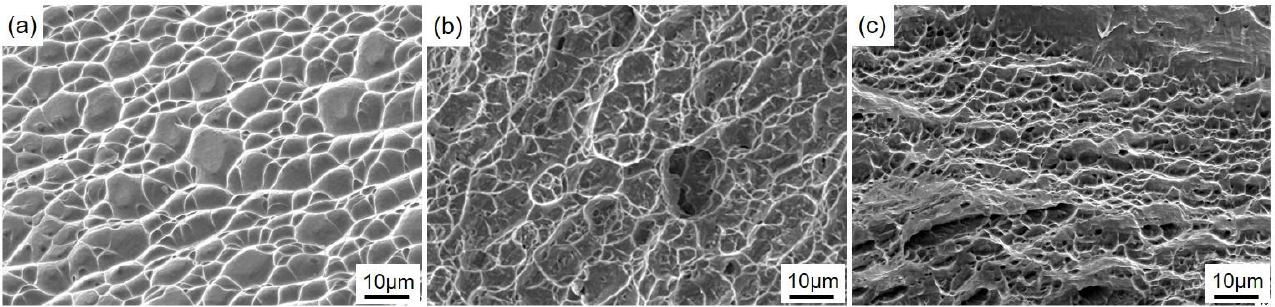
Figure 11. SEM-SE fracture morphologies of Ti-6Al-4V alloy deformed by 90% at different temperatures: ( a ) 850 °C, ( b ) 950 °C, ( c ) 1100 °C.